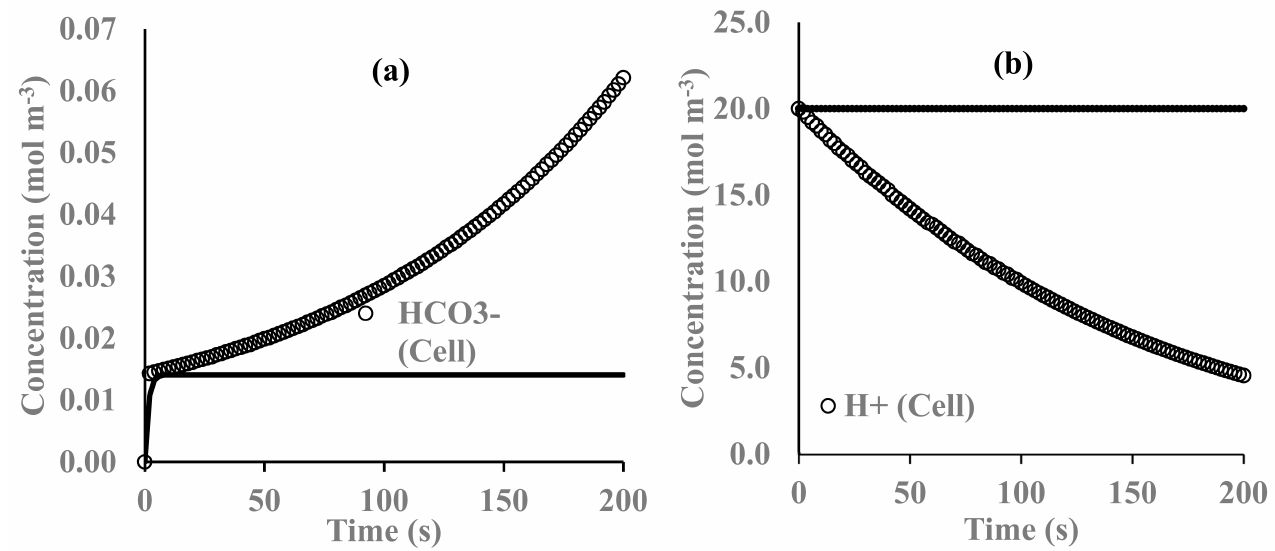
Figure 6. Comparison of the electrochemical cell and a batch reactor, ( a ) Bicarbonate ion concentration variation with time, ( b ) H + concentration variation with